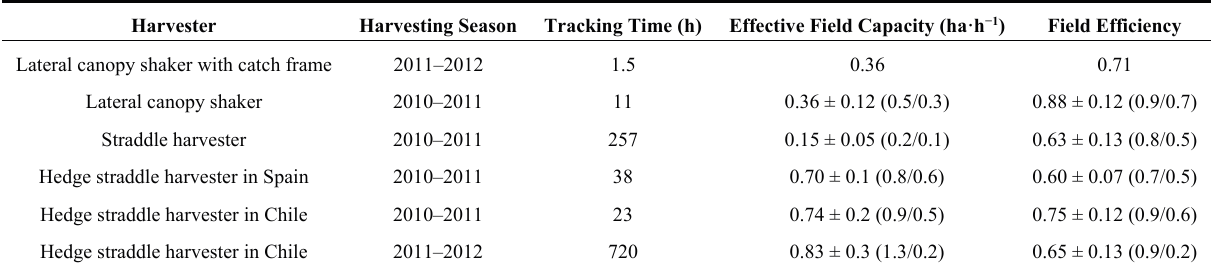
Table 2. Effective field capacity and efficiency for tracked olive harvesters. Values are mean ± standard deviation (maximum/minimum